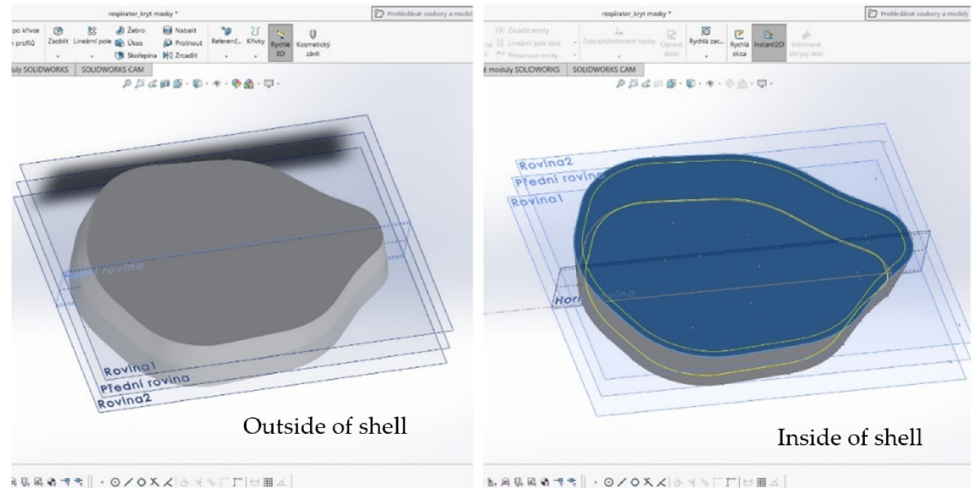
Figure 4. Joining profiles and creating a “shell”.